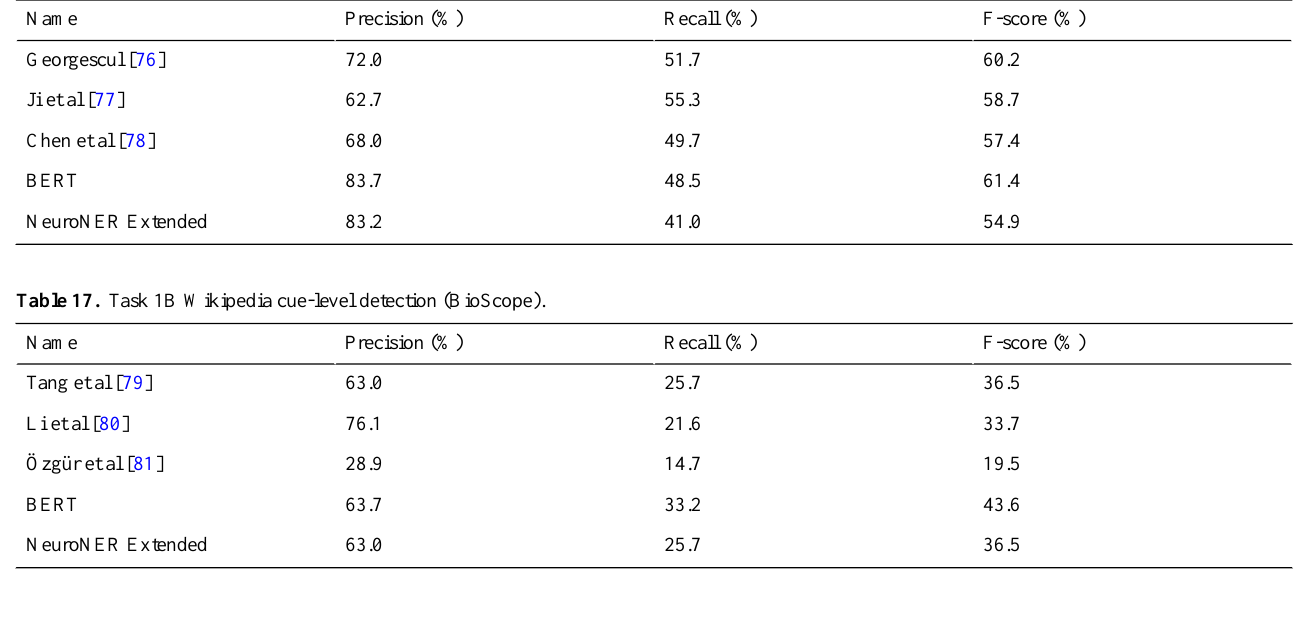
Table 16. Task 1B Wikipedia sentence-level speculation detection (BioScope).